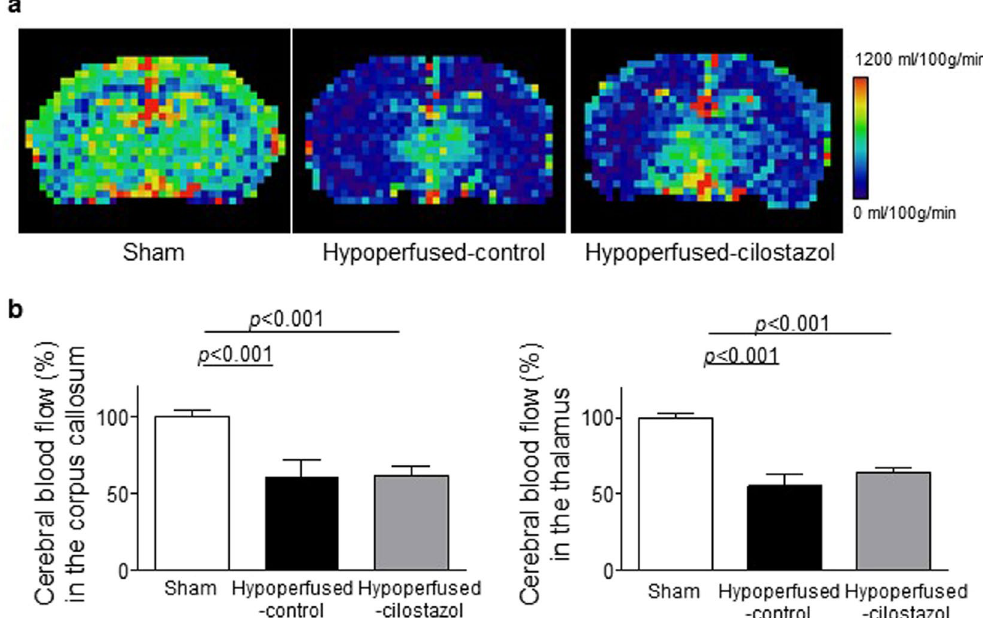
Figure 5. Cilostazol did not affect cerebral blood flow. ( a ) Representative images of ASL at the level of hippocampus. ( b ) There was an overall difference in CBF between the three groups in the corpus callosum ( F (2, = 11.0; p = 0.0004) and thalamus ( F = 33.05; p < 0.0001). CBF was significantly reduced in hypoperfused- 25) (2, 25) control and hypoperfused-cilostazol mice compared to sham mice in the corpus callosum ( p < 0.001 and p < 0.001) and the thalamus ( p < 0.001 and p < 0.001). Data represents mean ±